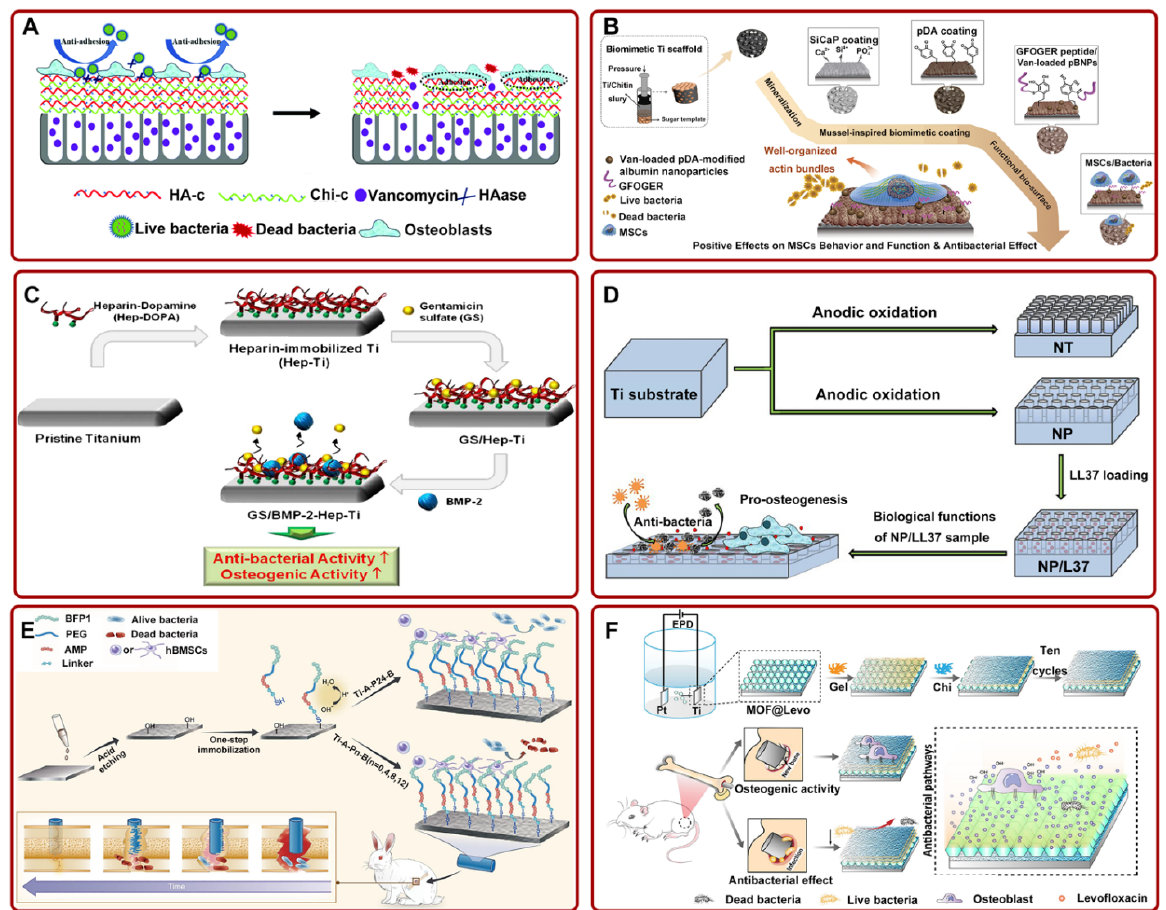
Figure 2. ( A ) Ti-based implants with multilayer, functional films inhibited bacterial adhesion and promoted osteoblast adhesion. Adapted with permission from Ref. [69]. Copyright 2018, Royal society of chemistry; ( B ) the preparation process diagram of Van-pBNPs/pep@pSiCaP-Ti scaffold for accelerating the osteogenic differentiation of BMSCs and inhibiting bacterial adhesion. Adapted